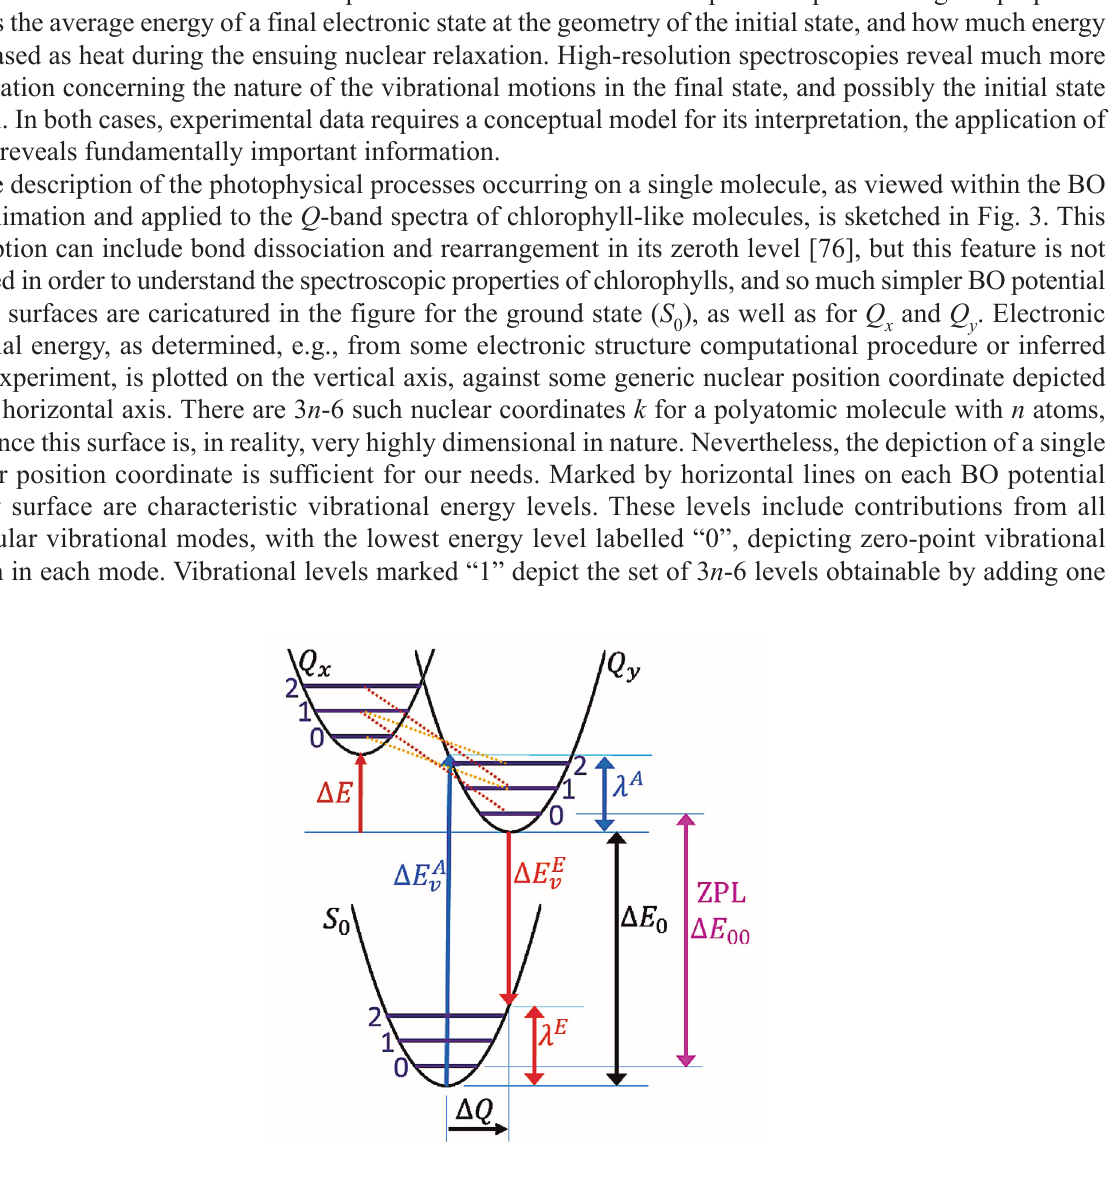
Fig. 3. Critical aspects pertaining to the Q -band spectra of chlorophylls sketched on potential energy surfaces (energy versus a generalized geometrical variable). Vibrational levels corresponding to 0, 1, and 2 vibrations present in only one of the many normal modes of vibration of each state are shown. Emphasized are labels descriptive of Q spectroscopy: the geometry difference between y the adiabatic state minima Δ 𝑄 ; the vertical absorption and emission energies, Δ 𝐸 𝑣𝐴 and Δ 𝐸 𝑣𝐸 , respectively; the associated reorganization energies 𝜆 𝐴 and 𝜆 𝐸 ; the adiabatic transition energy Δ 𝐸 ; and the energy of the ZPL origin Δ 𝐸 . Marked is also the adiabatic energy 0 00 gap of Q from Q Δ 𝐸 , and the non-adiabatic couplings indicated by dashed lines that link specific vibrational levels of Q and Q x y x y